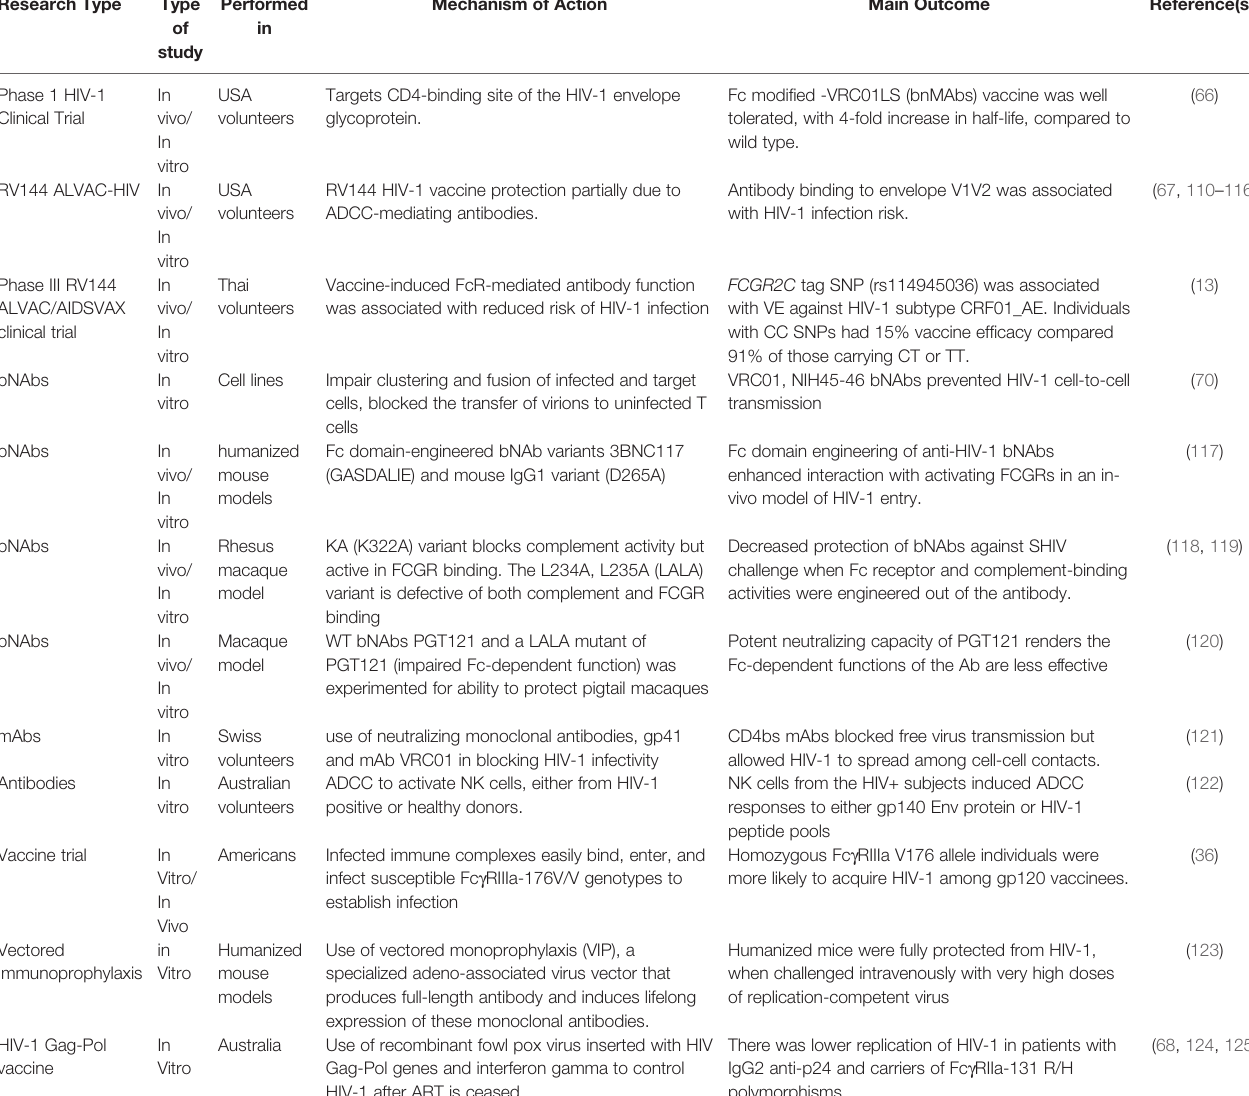
TABLE 2 | Vaccine and bNAb